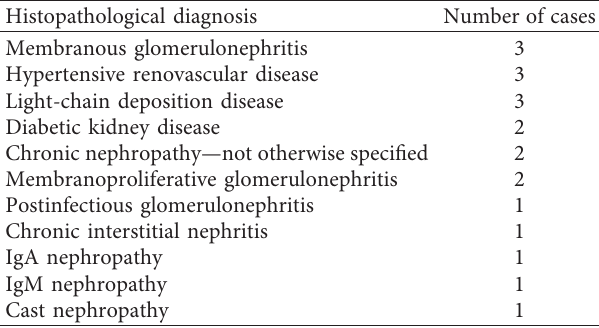
Table 2: Kidney biopsy histological diagnosis of patients with hematological conditions.